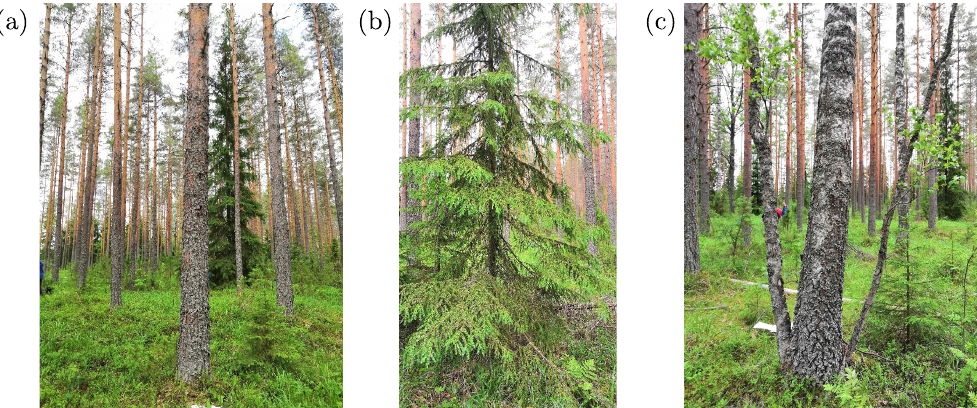
Figure 2. Example trees for each of the three tree species present in the two plots. ( a ) Pine. ( b ) Spruce. ( c ) Two birches. Note that the small birch on the right side of the large birch has a DBH below 5 cm and was thus not included in the set of reference trees. Table 1. Descriptive statistics of the two test sites corresponding to the summer of 2019. In the statistics, we take into account all trees that have a diameter at breast height (DBH) exceeding 5 cm during the first measurements conducted in 2014. Note that the trees that had fallen or harvested between the years 2014 and 2019 are not included in the statistics and they have also been excluded from the analysis in the remaining of the paper.